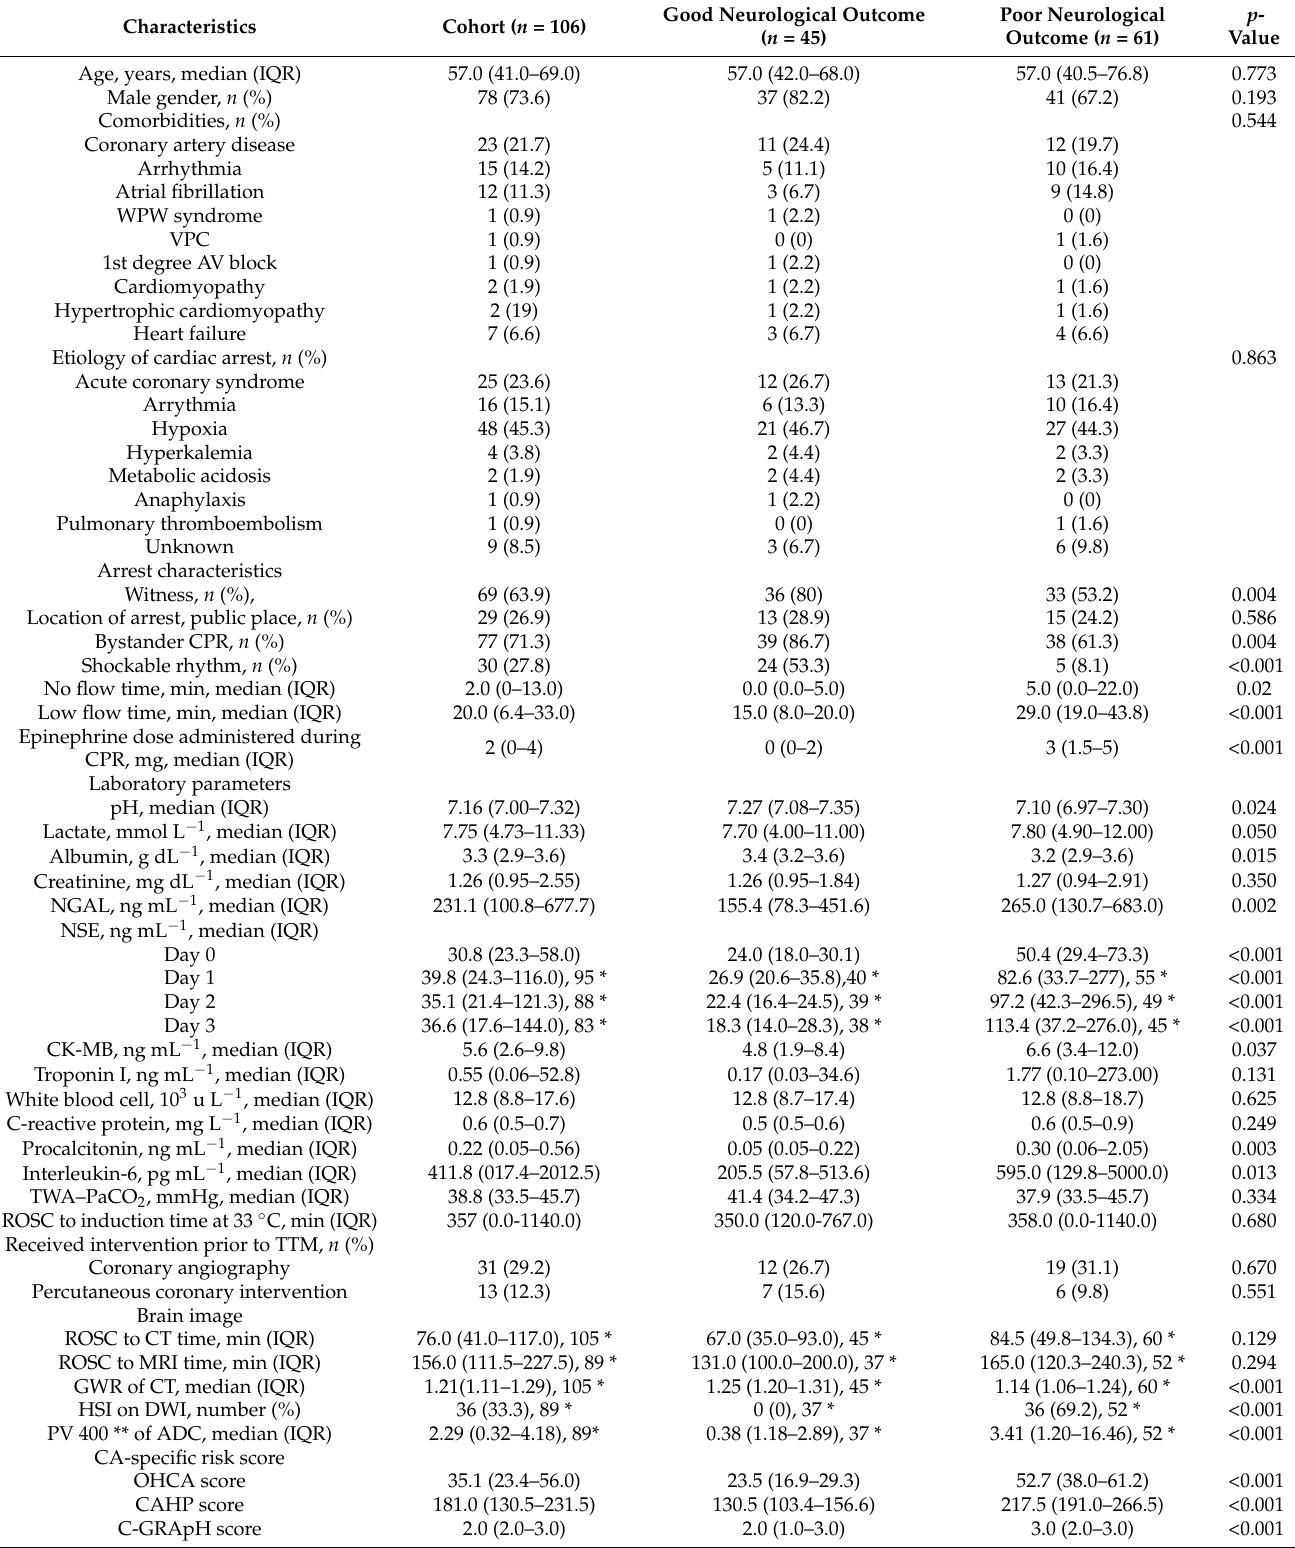
Table 1. Baseline demographic data and arrest